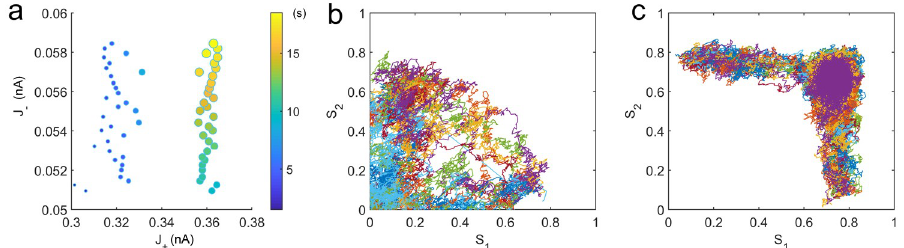
Fig 6. The emergence of the intermediate state can improve the performance in a WM task with an emphasis on flexibility to a new stimulus. (a)Better robustness against random fluctuations with the same flexibility to a new stimulus due to the emergence of the intermediate state. For any specific mutual inhibition J , we choose a pair of self- − excitation J + , which correspond to the same flexibility to a new stimulus from the data shown in Fig 4(a). Each pair of J + corresponds to different robustness to random fluctuations. The circles on the right side indicate the robustness against random fluctuations in terms of both size and color(the escape time from the original memory attractor) for systems in the presence of the intermediate state. The circles on the left side indicate the robustness for systems without the intermediate state. For any specific pair of J + with the same J − and also the same flexibility to new signals, the robustness against random fluctuations is better for the system with the presence of the intermediate state(circles on the right side). (b-c) The distributions of the single trials switching from the target-related memory state to the distractor-related one in the absence and presence of the new intermediate state. It is obvious that the pathways are more restrained with the intermediate state. The self-excitation J + = 0.30, 0.36 nA , respectively with the mutual inhibition J − = 0.05 nA